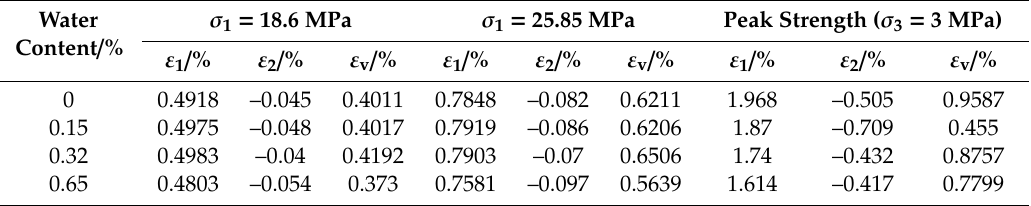
Table 1. Deformation parameters of each sample in